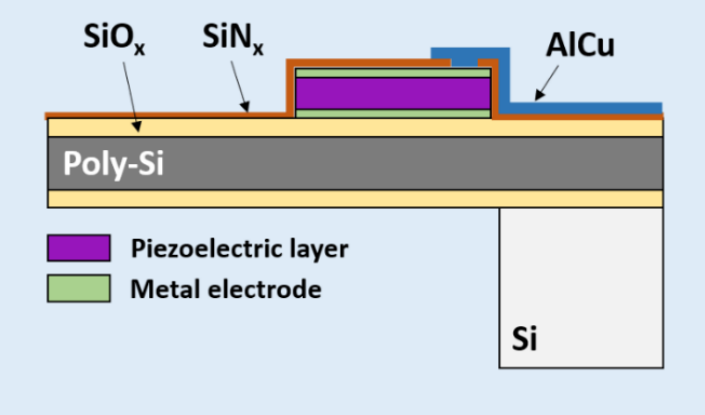
Figure 1. Piezoelectric cantilever cross-section layout, with the description of material layers.